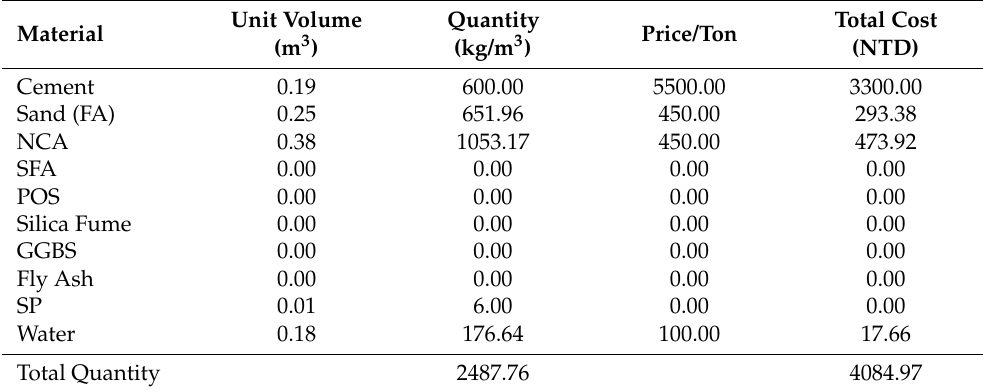
Table 7. C-1-100%—normal concrete in NTD.